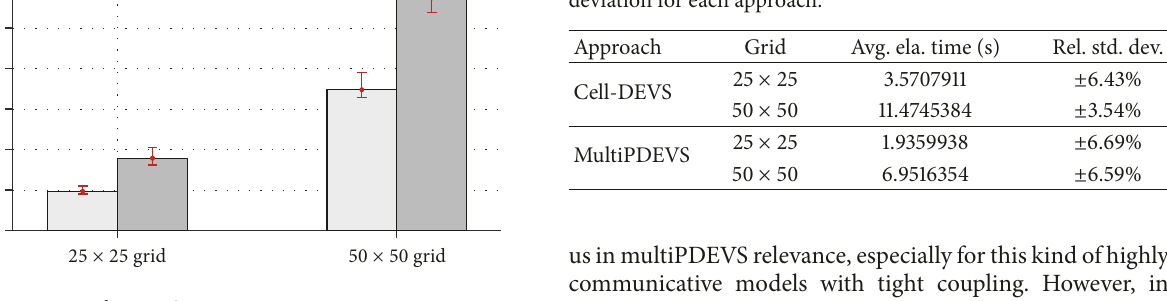
Table 2: Performance comparison results of multiPDEVS and Cell- DEVS showing average elapsed real time and relative standard deviation for each